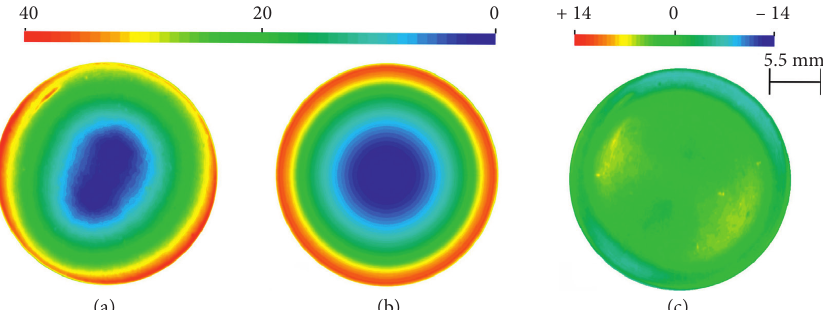
Figure 5: Residual birefringence distribution. (a) Digital photoelasticity experiment. (b) Finite element simulation. (c) Difference between experiment and simulation [27].